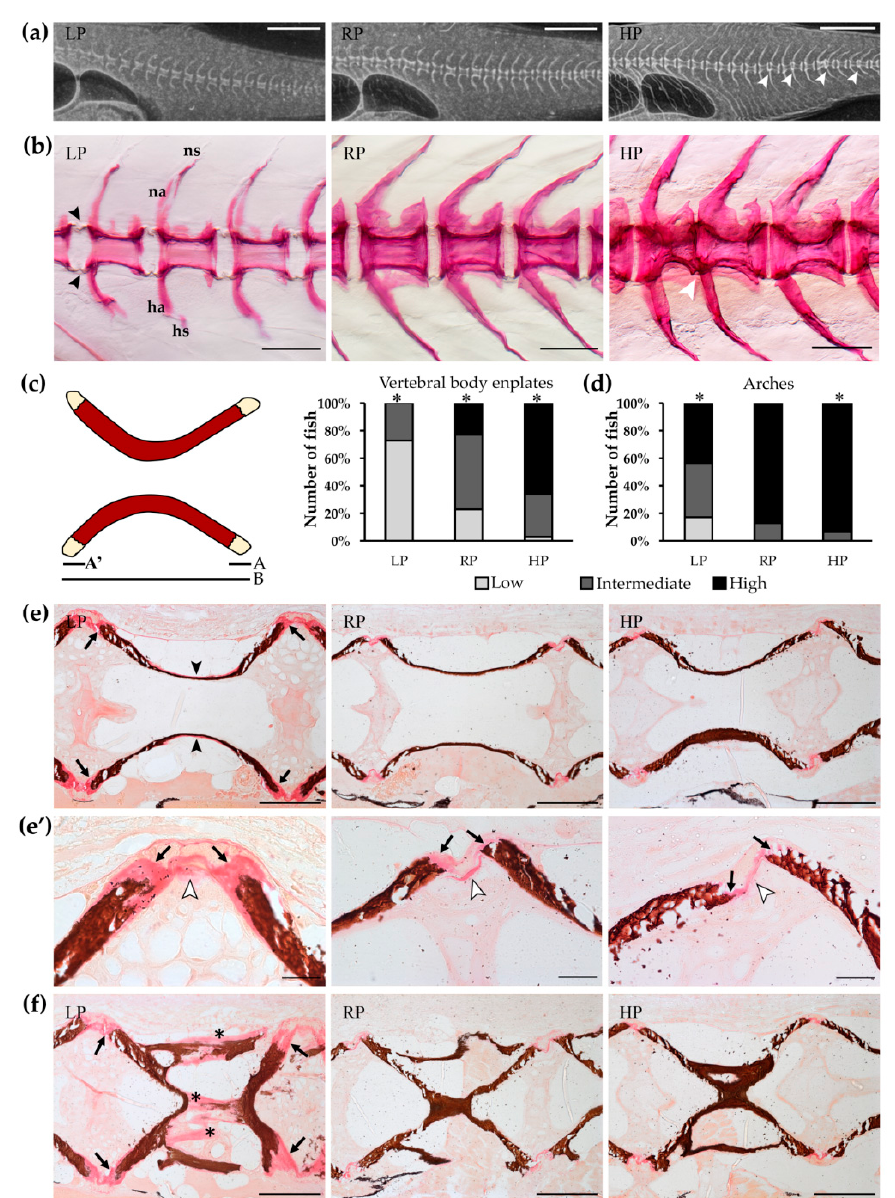
Figure 2. Mineralisation levels of vertebral column after two months of dietary treatment. ( a ) Vertebral column of low P diet (LP) treated animals is characterised by reduced radiodensity compared to controls (RP) and high P diet (HP) treated animals. HP zebrafish present multiple vertebral body fusions (white arrowheads). Scale bar: 1 mm. ( b ) Alizarin red S staining of vertebral columns shows vertebral body endplates (black arrowheads) characterised by low mineralisation levels in LP animals, intermediate mineralisation in controls and high mineralisation levels in HP animals. HP zebrafish present vertebral body fusion (white arrowhead). Neural (na) and haemal arches (ha) are low-mineralised and their spines (ns, hs, respectively) are deformed in LP individuals compared to RP and HP zebrafish. Scale bar: 200 µ m. ( c ) Quantitative analysis of vertebral body endplate mineralisation: the non-mineralised endplate is expressed as percentage of the total non-mineralised endplate length (A + A’) over the total vertebral length (B), (A + A’) / B. Chi squared or Fisher’s exact test, pairwise comparison, *: p < 0.05. ( d ) Qualitative analysis of arch mineralisation levels. Please see Materials and Methods for further details. Chi squared or Fisher’s exact test, pairwise comparison, *: p < 0.05. ( e ) Sagittal sections of vertebral bodies show large areas of non-mineralised matrix at the level of the vertebral endplates (black arrows) in LP animals compared to RP and HP animals. LP individuals present also a thin osteoid layer in the outer part of